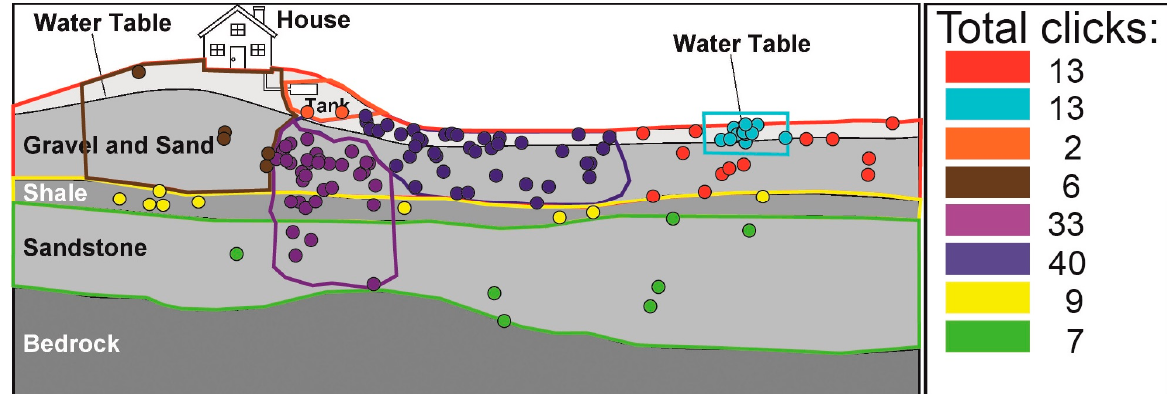
Figure 5. Polygons and student clicks in response to the prompt, “The septic tank under the house leaks for several months before being repaired. Click where you expect the pollution will be found in the groundwater”. The correct region, labeled in dark purple ( n = 40), includes vertical and horizontal flow associated with gravity and topography, respectively. The light purple region encompasses only vertical groundwater flow (gravity) ( n = 33). Other regions were bounded based on clusters of student responses and natural breaks in the data.